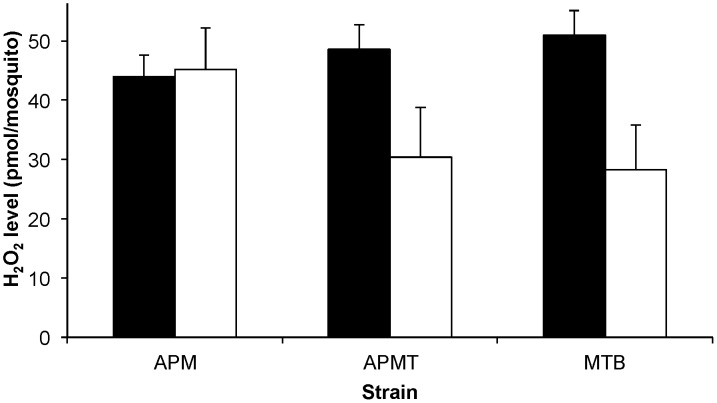
ROS levels in Ae. polynesiensis strains.The concentration of H2O2 was measured in APM, APMT and MTB after feeding on sucrose (black) and 24 hours after a blood meal (white). Sucrose fed MTB had significantly higher levels of ROS than APM (ANOVA, p<0.05). Blood feeding was associated with a significantly reduced ROS level in APMT and MTB (ANOVA, p<0.05) but not APM (p = 0.75). After blood feeding, APM maintained higher ROS levels than APMT and MTB (Tukey, p<0.05), which were equivalent (p = 0.9). The data shown are the means of five replicates.